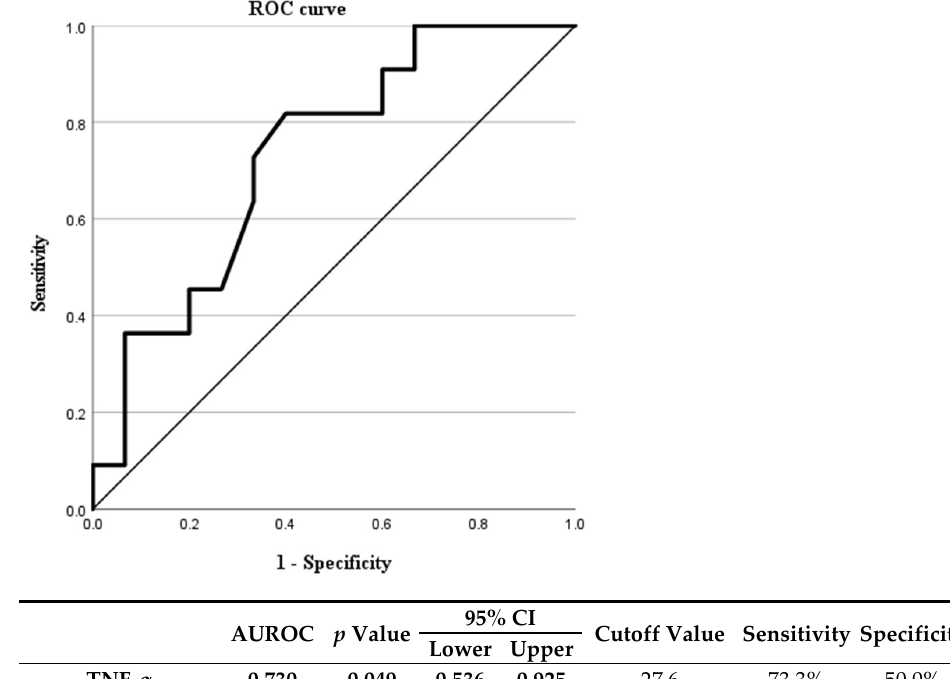
Figure 4. Diagnostic capability of initial TNF-α concentration with receiver operating characteristics curve in the patients whose infliximab trough concentration measured before the fourth administra- tion was less than 3 µg/mL. TNF-α; Tumor necrosis factor-α, and AUAROC; Area under receiver operating characteristic.